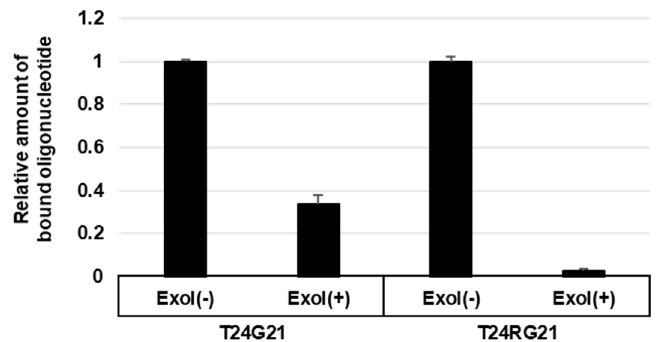
Figure 5. Flag-hnRNP U 683C fusion proteins made in E. coli were IP:d with anti-Flag agarose gel. IP were mixed with T24G21 and T24RG21. After washing the beads, exonuclease was added and incubated. After washing the beads, bound oligonucleotides were purified and were pulled down by streptavidin magnetic beads. After washing the beads, adapter oligonucleotide (T24G21 linker or T24RG21 linker) was mixed and bound adapter oligonucleotides were detected by qPCR. See Supplemental Figure B.